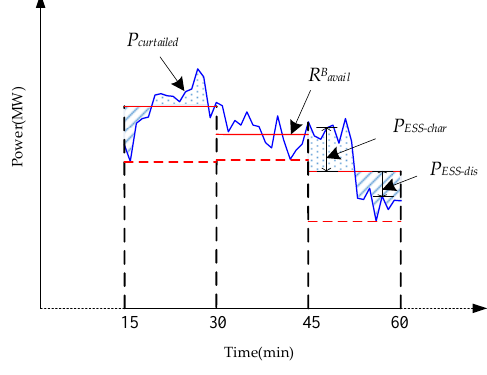
Figure 4. Mean value method control strategy of ESS.